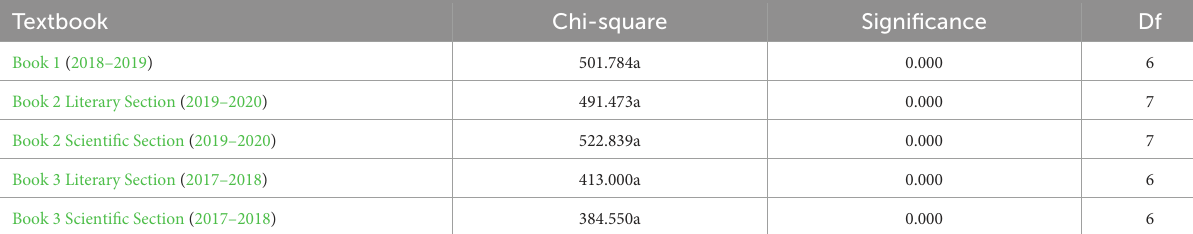
TABLE 4 Chi-square results for overall speech language functions in 21st Century English for Libya secondary 1, 2, and 3 course books and workbooks.